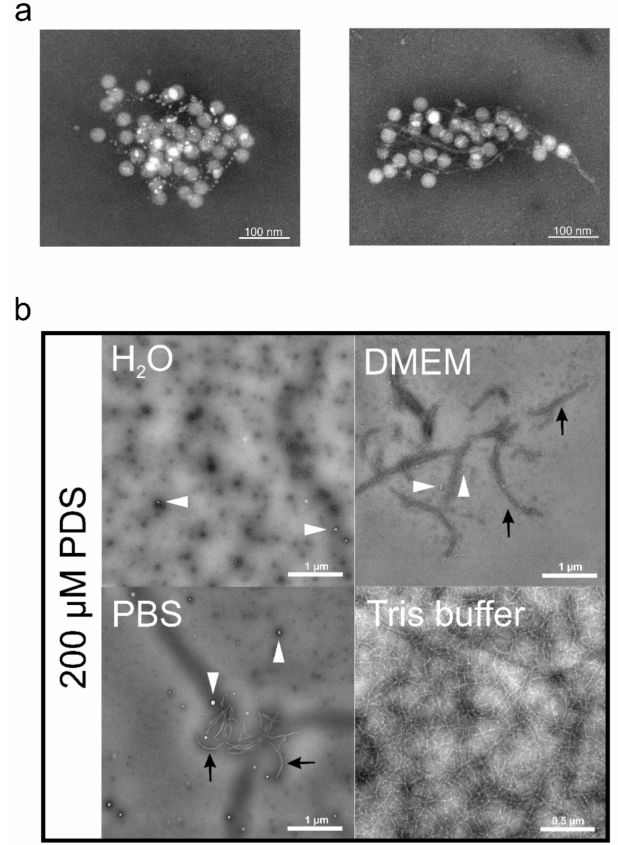
Figure 5. PDS Fibrils. ( a ) Two examples of RV entrapped by PDS fibrils. RV-A2 was mixed with PDS at 20 µ M in Tris buffer, transferred onto EM grids, stained with 2% phosphotungstic acid (pH 7.4), and viewed with an electron microscope. Note the pearls-on-a-string-like appearance of the filaments in the left panel; ( b ) solvent effect on PDS fibril formation. PDS (200 µ M final concentration) dissolved in the solutions indicated was applied onto EM grids, stained, and viewed as in ( a ). The white arrowheads point to larger amorphous aggregates; the black arrows point to ‘protofibrils’. Both panels are reproduced from ref. [25] with